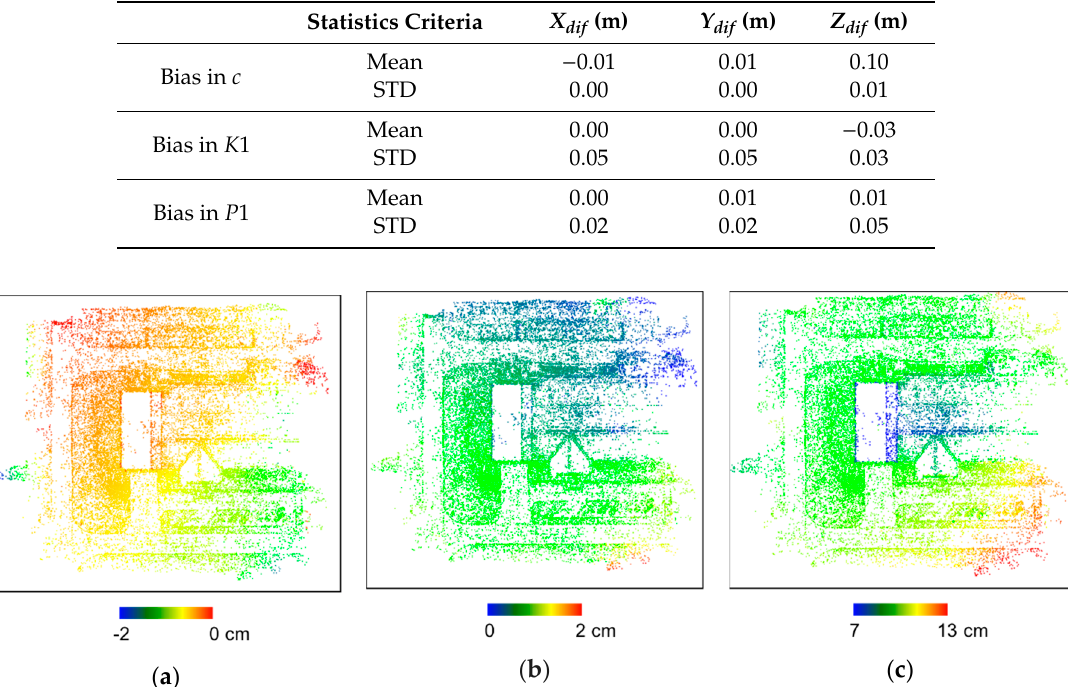
Figure 7. Top view of the sparse point cloud colored by ( a ) X discrepancy, ( b ) Y discrepancy, and ( c ) Z discrepancy caused by a bias in the principal distance for the A-1 dataset.